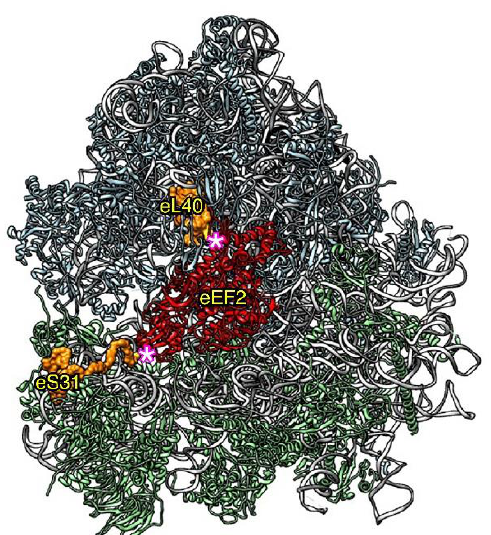
Figure 4. Relative position of ribosomal proteins eL40 and eS31 (orange) within the large and the small ribosomal subunit, respectively, with respect to the binding site of the GTPase eEF2 (red). The remaining ribosomal proteins are colored in blue (large subunit) or green (small subunit) and the 25S and 18S rRNA in pale gray. The 5.8S and the 5S rRNA are shown in dark gray and black, respectively. The representation was generated with the UCSF Chimera program, using the atomic model of the cryo-EM structure V of the yeast 80S ribosome bound to the Taura syndrome virus IRES (not shown) and sordarin-stalled eEF2·GDP (PDB 5JUU). Note that eL40 could be modelled from its third residue (E79) and eS31 from its sixth residue (K82); these are highlighted by a pink asterisk. Due to the positions of eL40 and eS31 within 60S and 40S ribosomal subunits, respectively, the assembly of non-cleaved Ubi1/2 or Ubi3 is expected to sterically interfere with the binding of eEF2 to the ribosomal GTPase-associated center.